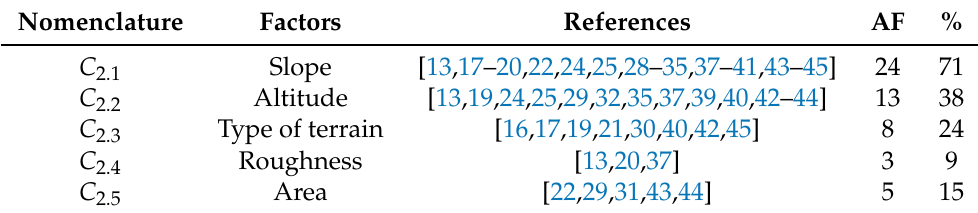
Table 8. Geographic Category ( C 2 )—Onshore optimal location. Quantitative analysis.